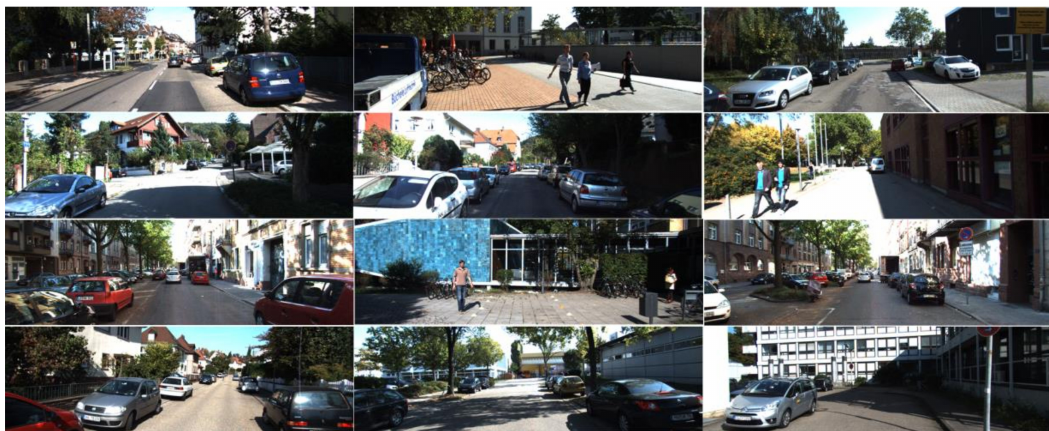
Figure 4. The KITTI data set, co-founded by the Karlsruhe institute of technology and the Toyota institute of technology, is the largest evaluation data set of computer vision algorithms in the world.